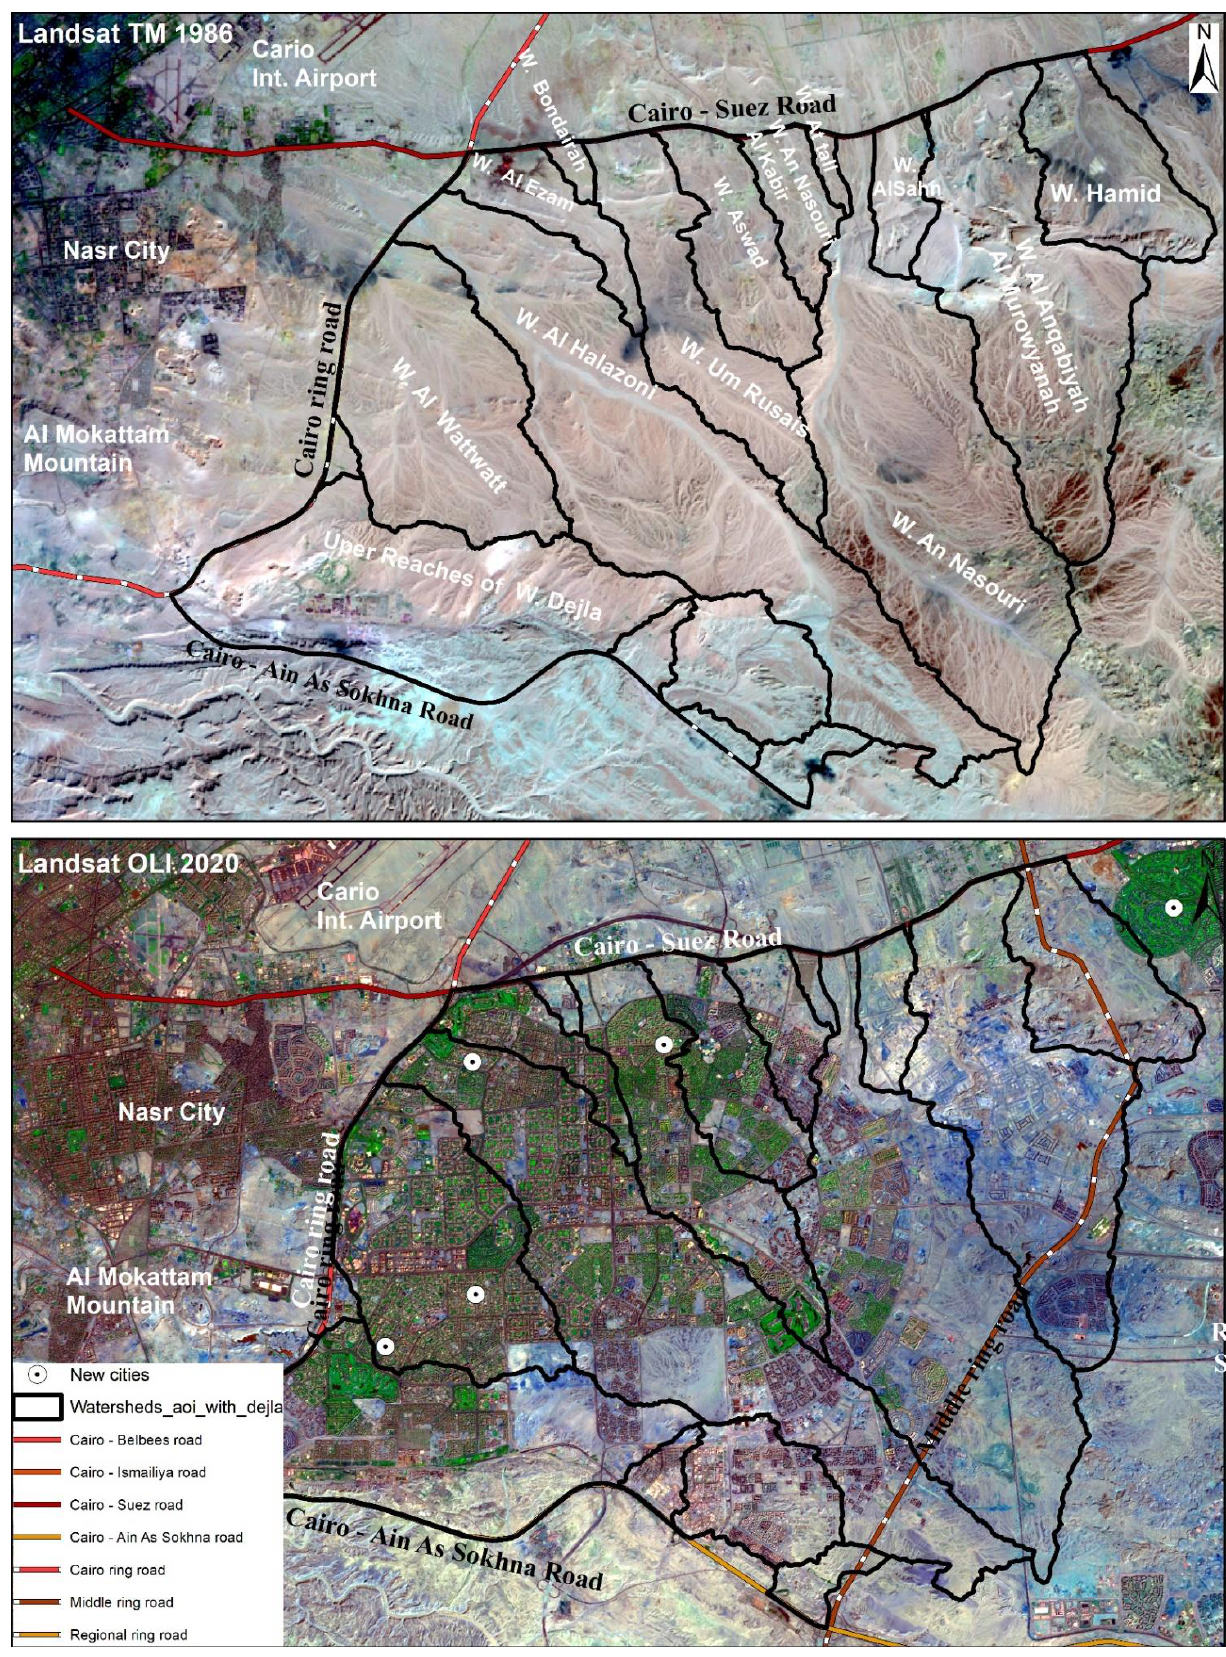
Figure 2. The spatial pattern of the spatial urban expansion through the time period 1986–2020.